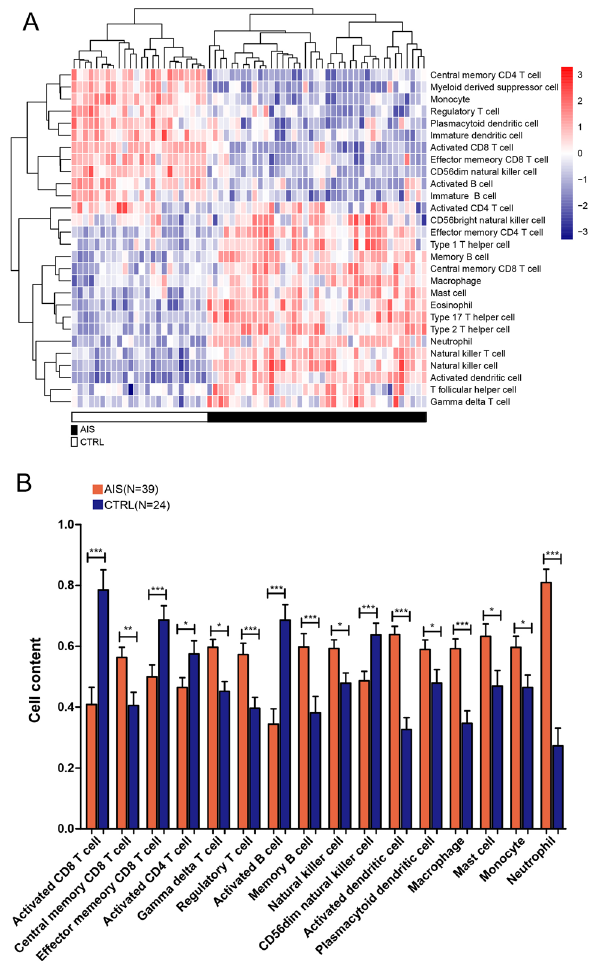
Figure 2. The immune landscape of samples in GSE16561. ( A ) Heatmap of immune cell proportion distribution of samples between AIS and control groups, implemented by by GSVA package in R3.6.1 (http:// www. bioco nduct or. org/ packa ges/ relea se/ bioc/ html/ GSVA. html). ( B ) Bar chart of immune cell types with significant differences in distribution between AIS and control